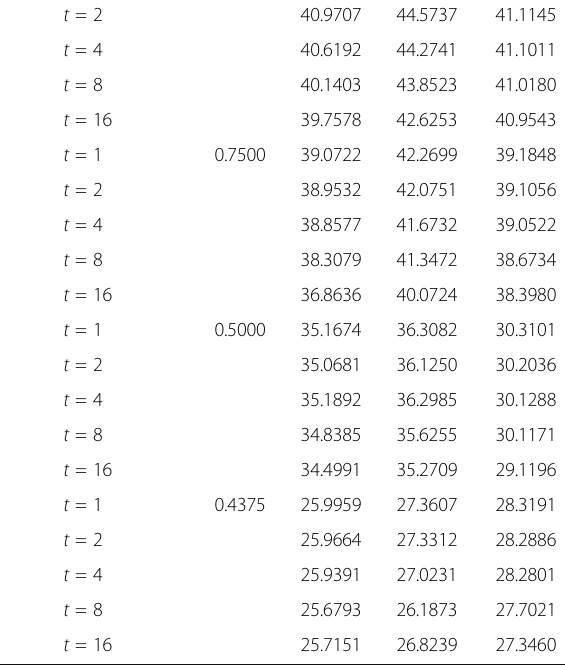
Table 3 Comparison of the PSNR of reconstructions with different dimensions of Gaussian measurement